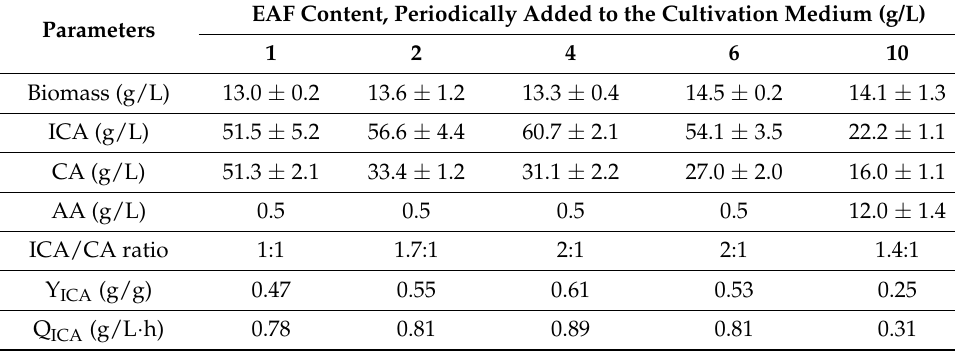
Table 6. Effect of EAF on the growth of Y. lipolytica VKM Y-2373 and ICA production.